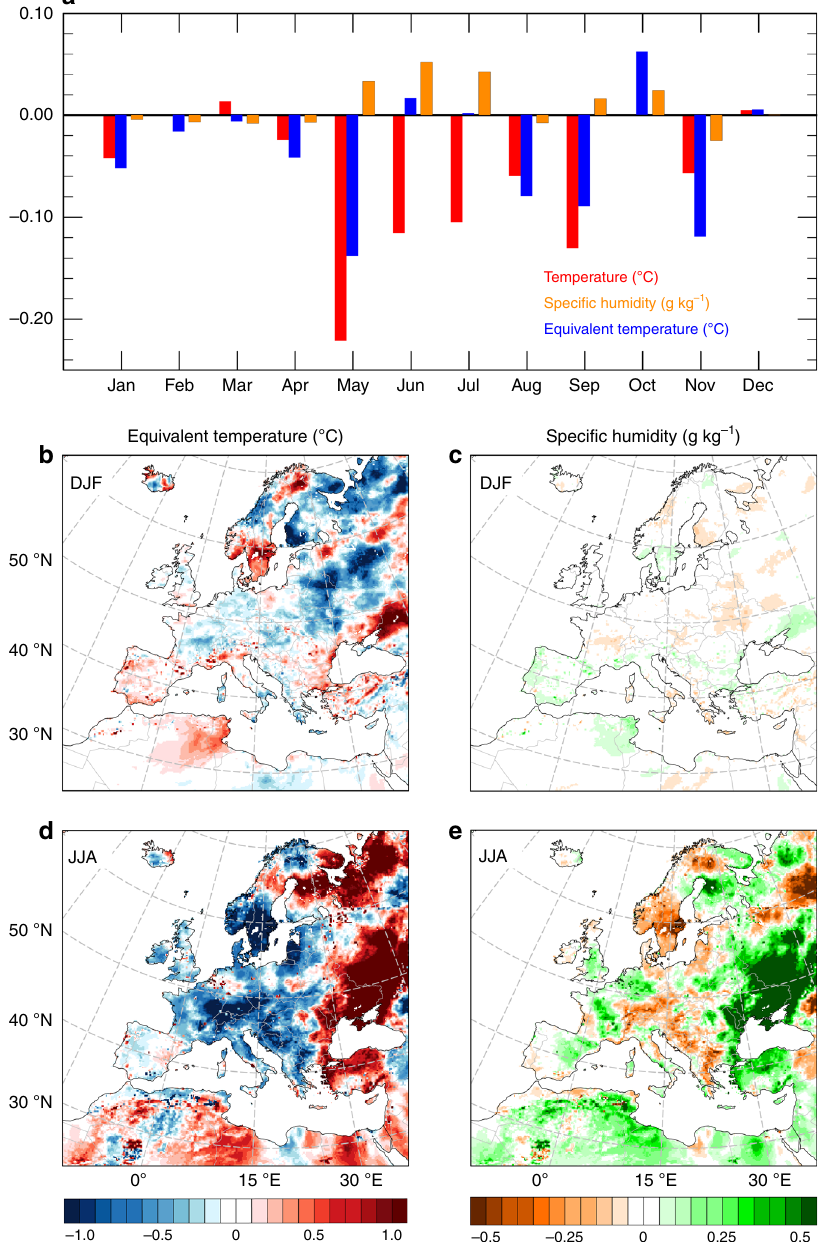
Fig. 5 Seasonality of the changes in equivalent temperature and speci fi c air humidity from the recent land cover changes in Europe. Comparison of the mean monthly differences (LC2015 – LC1992) in air temperature, equivalent temperature, and speci fi c air humidity ( a ); average equivalent temperature changes (°C) in winter ( b ) and summer ( d ); average speci fi c humidity changes (g kg − 1 ) in winter ( c ) and summer ( e ). December, January and February (DJF); June, July and August